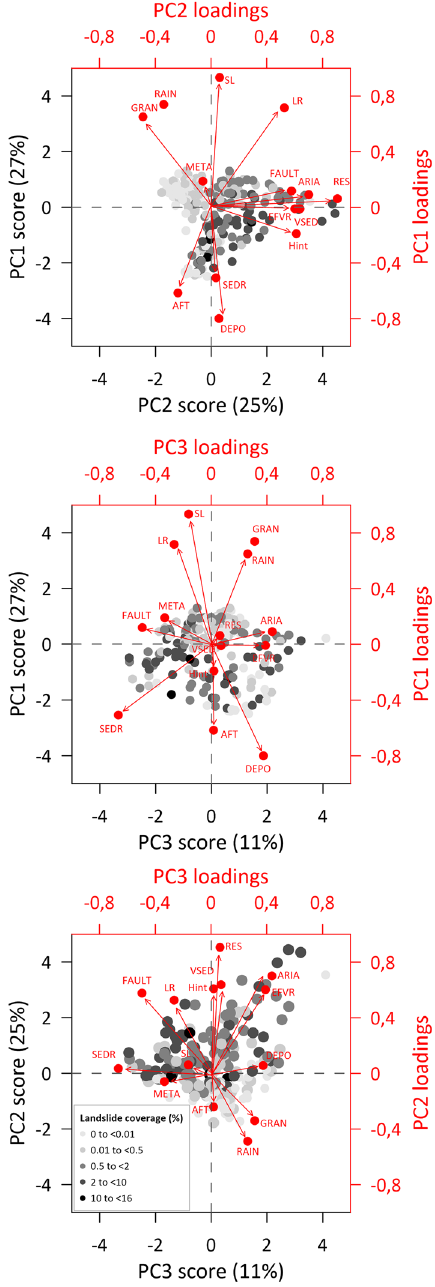
Figure 5. PCA results showing principal component scores and loadings for the first three principal components (PC1–PC3). Labels abbreviations: ARIA: Aria Intensity, AFT: mean AFT age, DEPO: coverage (%) by Quaternary unconsolidated deposits, EFVR: coverage (%) by effusive volcanic rocks, FAULT: mean fault density, GRAN: coverage (%) by granitoid rocks, Hint: mean hypsometric integral, LR: mean local relief, META: coverage (%) by metamorphic rocks, RAIN: mean annual precipitation totals, RES: residual relief, SL: mean slope, SEDR: coverage (%) by sedimentary rocks; VSED: coverage (%) by volcanic-sedimentary